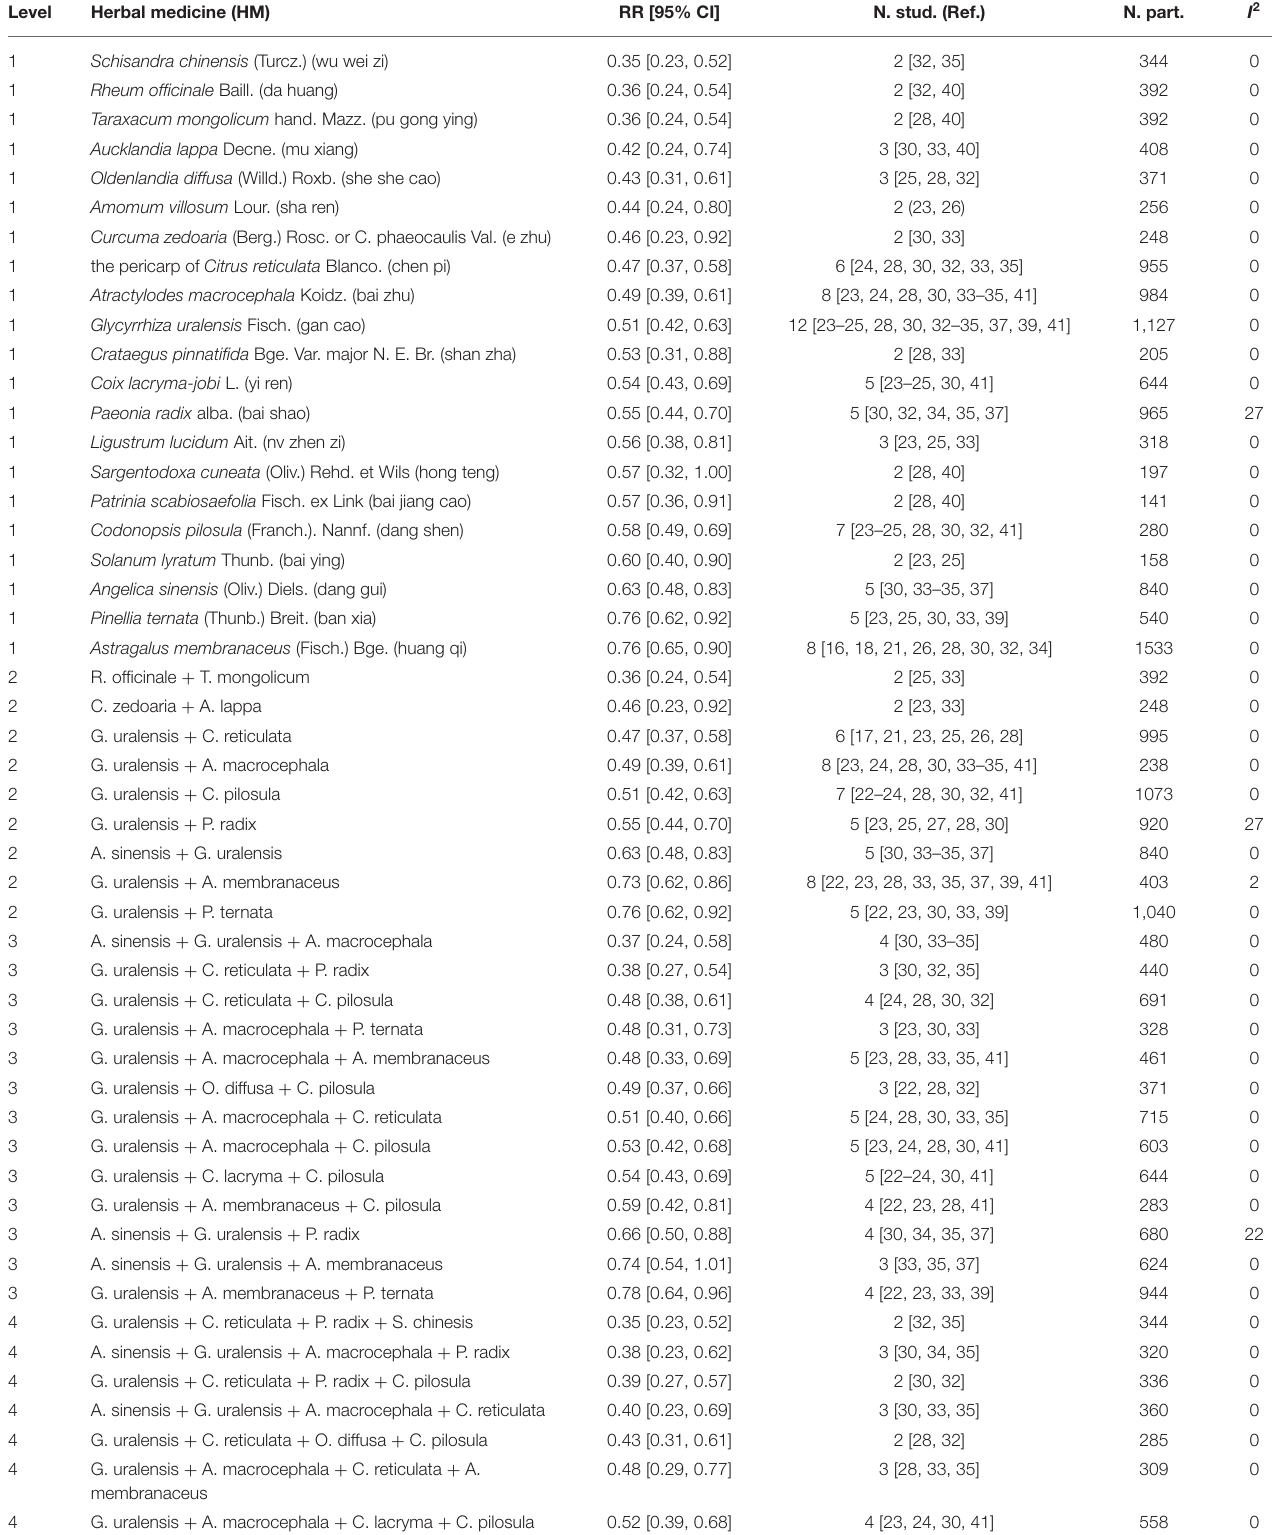
TABLE 2 | Effects of specific HMs on alleviation of chemotherapy-induced gastrointestinal toxicity: single HMs and combinations.